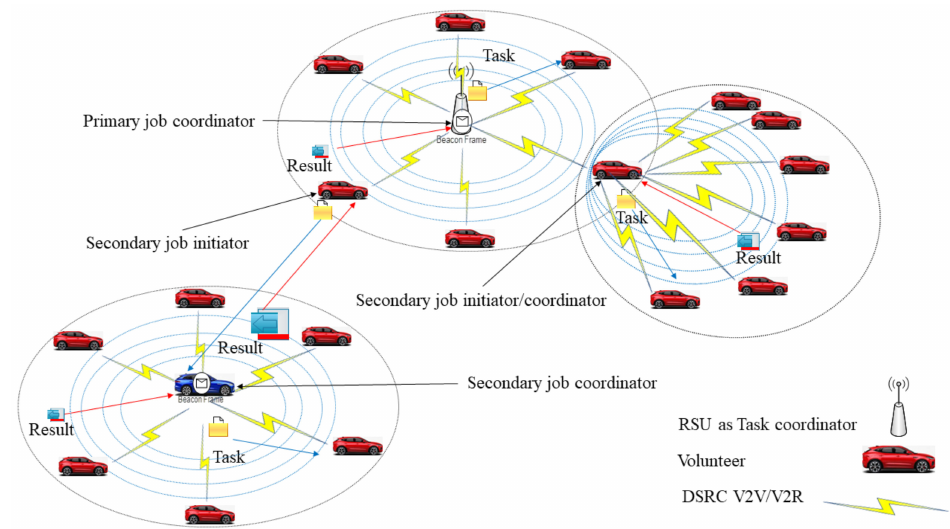
Figure 2. System Model for Hybrid